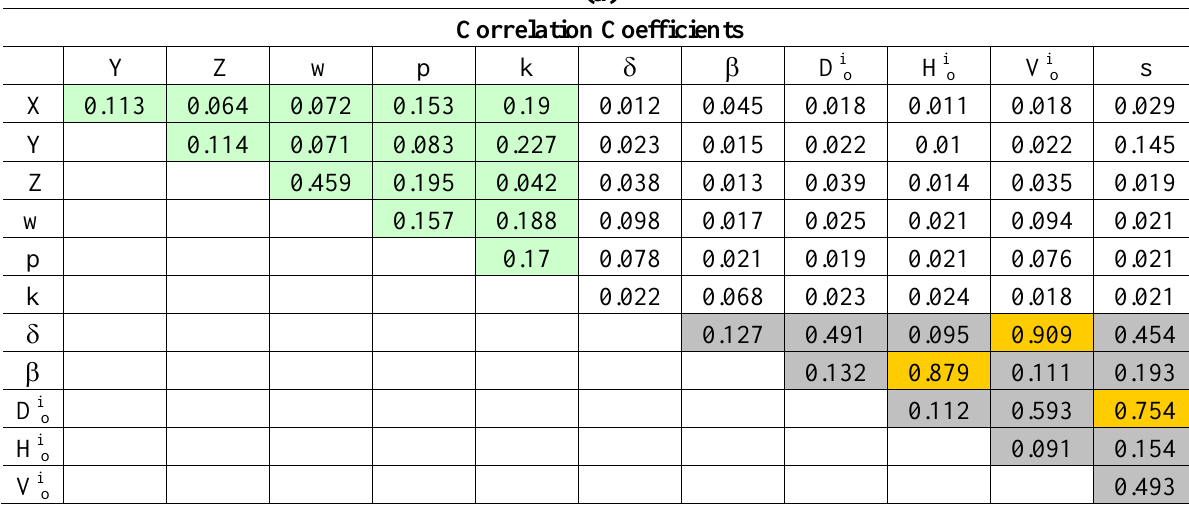
Table 2. (a) Correlation Coefficients from the Original Analysis [5]; (b) Correlation Coefficients with Inclined